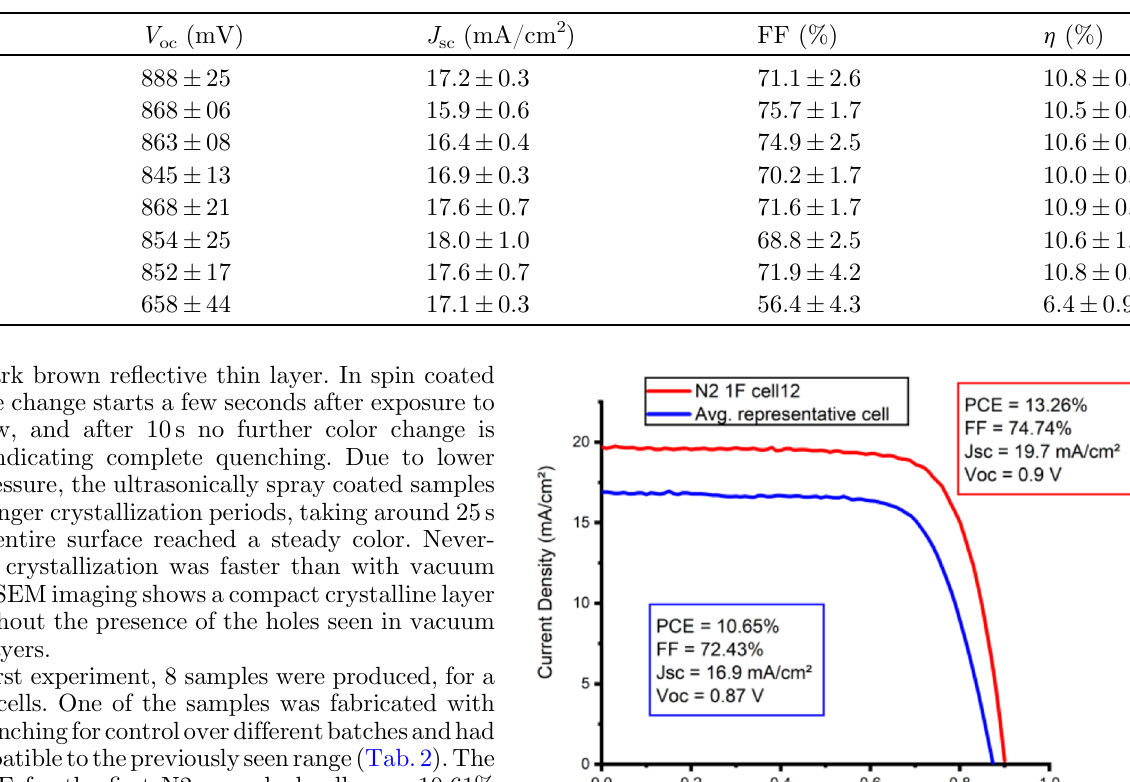
Table 2. Average performance of perovskite solar cells fabricated by USSC, with additional vacuum (control sample) and gas quenching (with standard deviation).